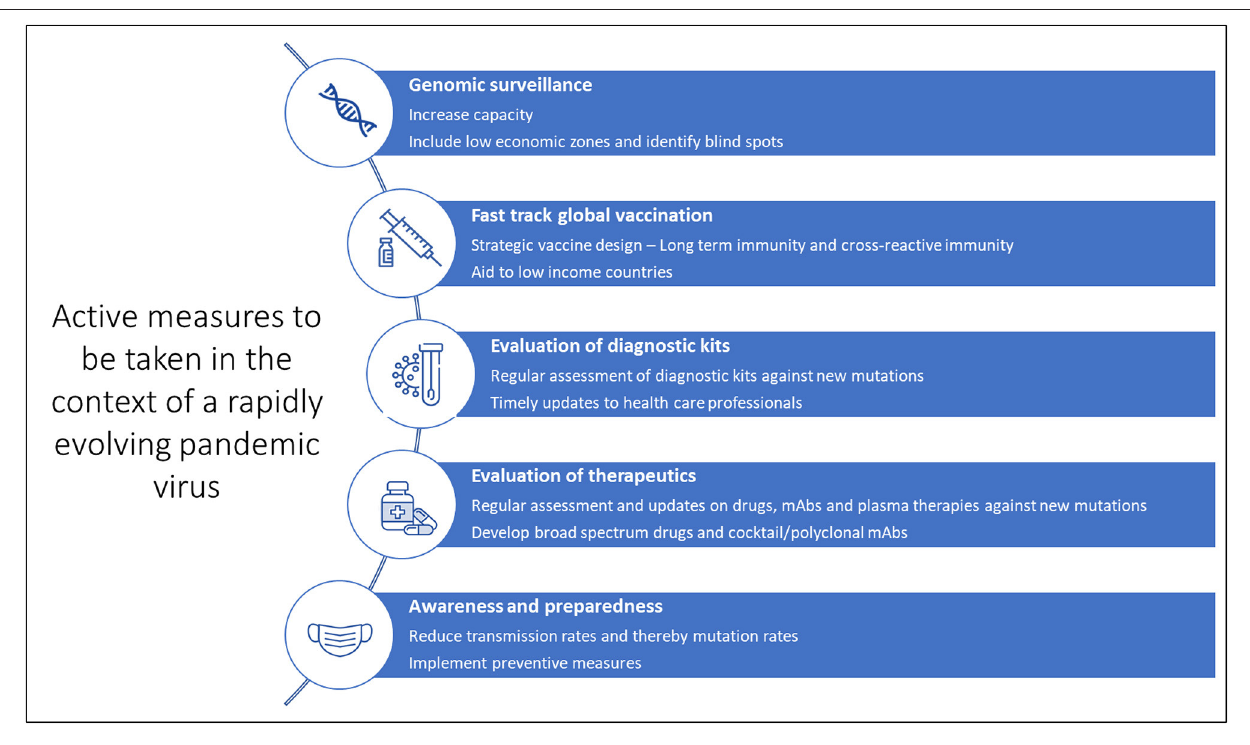
FIGURE 4 | Active measures against the evolving